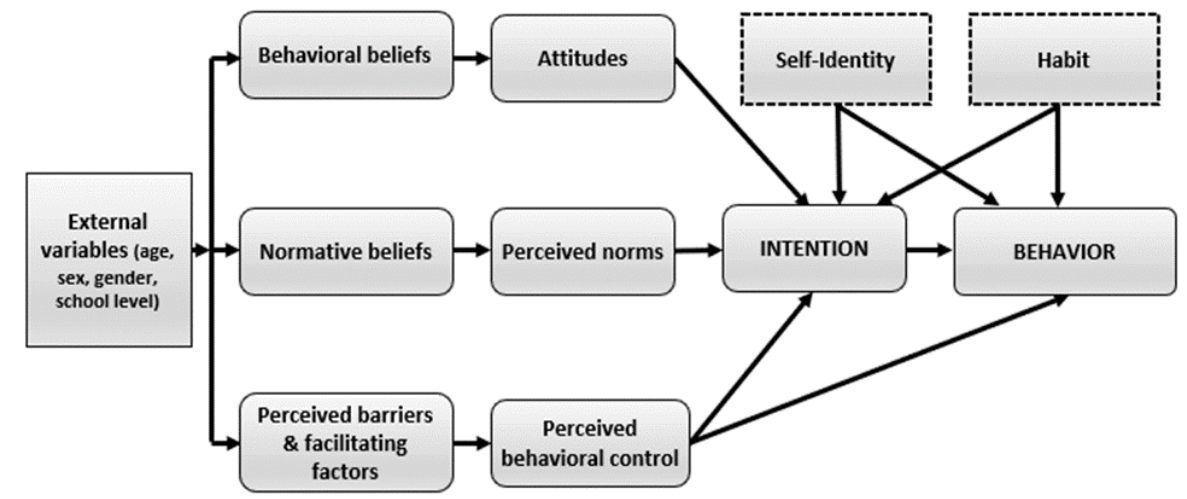
Figure 1. Theoretical framework (adapted from Fishbein and Ajzen, 2010 [13]). Note: Variables in dotted lines were added to the Reasoned Action Approach.